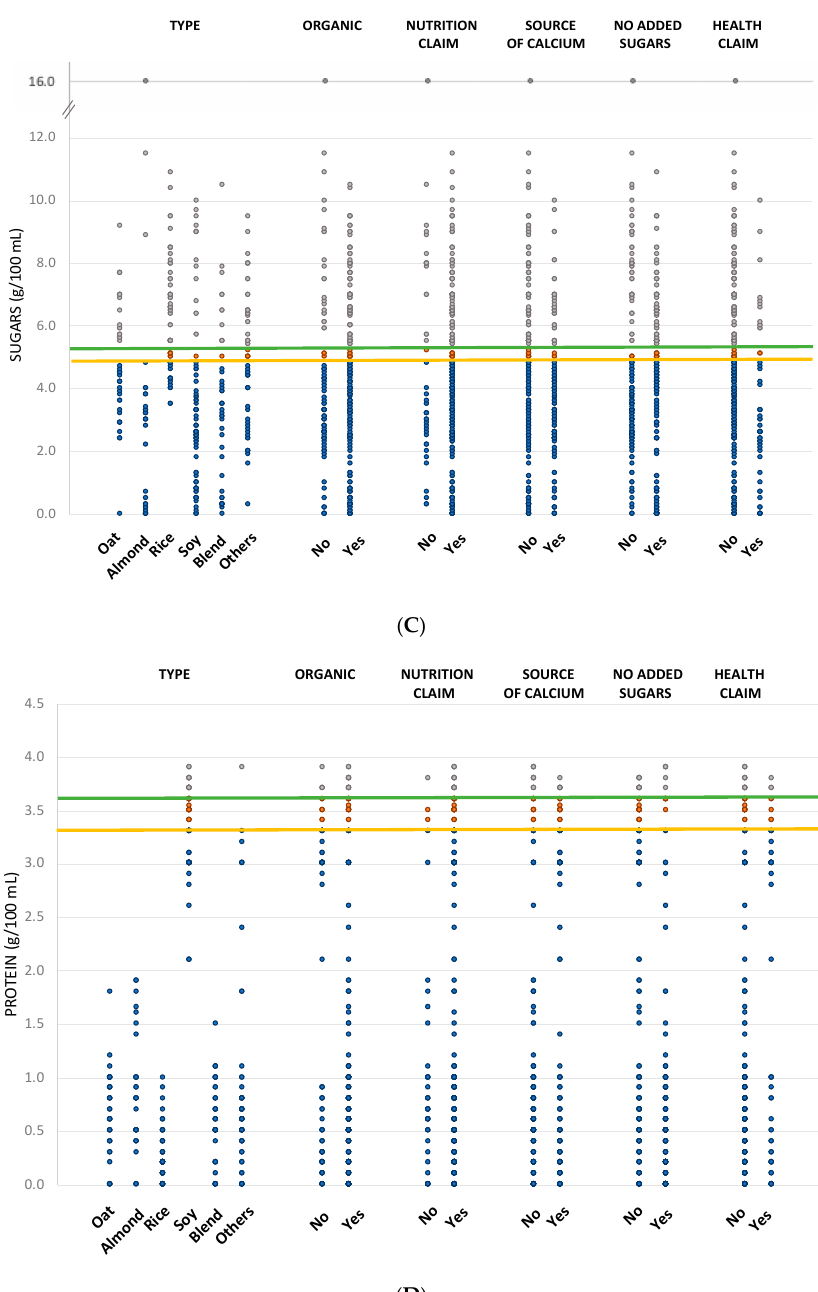
Figure 2. Energy ( A ), total fat ( B ), sugar ( C ), and protein ( D ) content of the analyzed plant-based drinks grouped by product types, organic or non-organic, having or not nutrition claim, health claim, “no added sugar” claim, and “source of calcium” claim. The orange line represents the value of regular milk, while the green line the value of skimmed milk. Blue, orange, and grey dots represent the referring values of each product lower, within, or higher than the reference values.